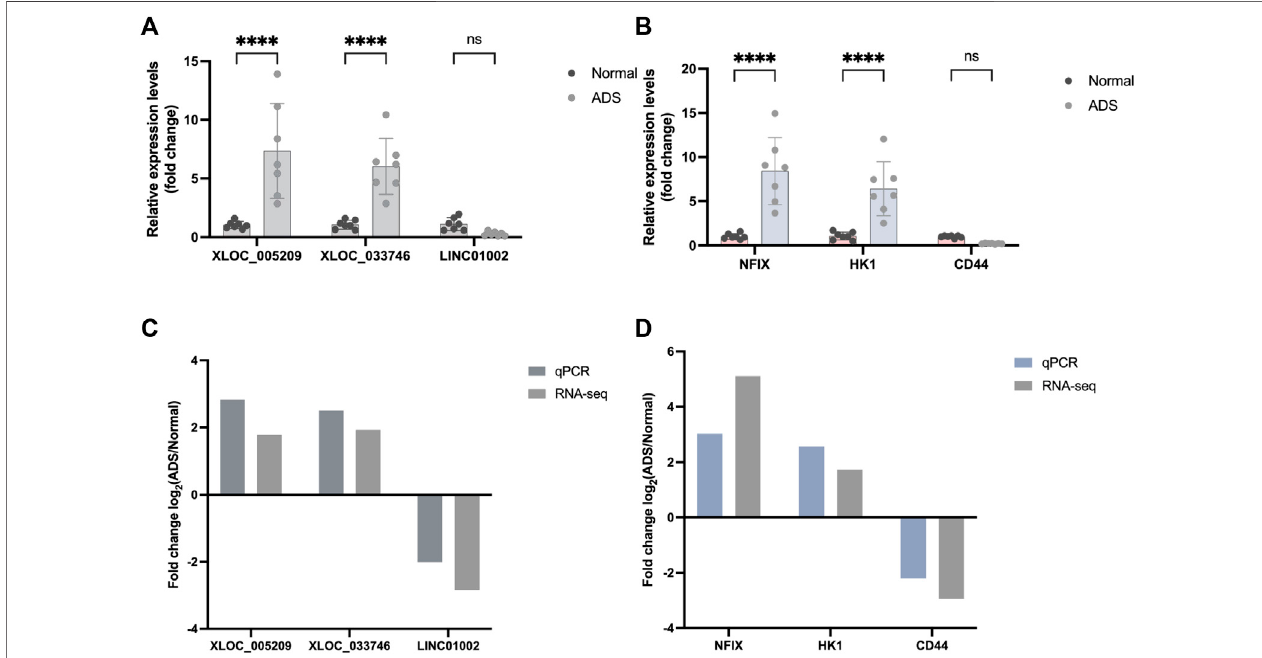
FIGURE 8 | Validation for the expression of signi fi cant transcripts by quantitative RT-PCR. (A) Relative expression levels of qRT-PCR validation of three lncRNAs ( XLOC_005209, XLOC_033746 , and LINC01002 ) and (B) three mRNAs ( HK1, NFIX , and CD44 ) are shown comparing ADS and normal groups. (C – D) Comparing qPCR results and RNA-seq data reveals a good correlation between such two methods. The heights of the columns represent the fold changes (log2 transformed) computed from the qPCR and RNA-seq data. Data are presented as mean ± SD, n = 7. * p -value < 0.05, ** p -value < 0.01, *** p -value < 0.001, and **** p -value <